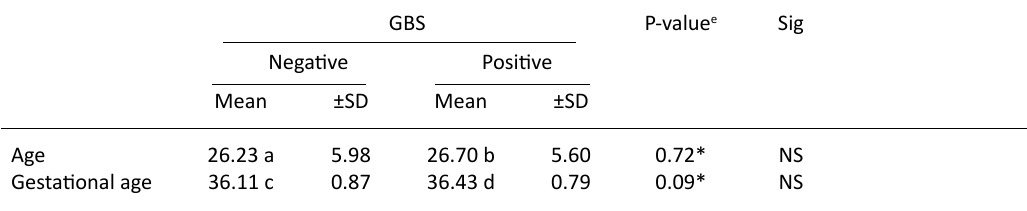
Table 2. Relationship between parity and GBS result among cases Parity P-value a Sig P0 P1-2 P3-4 N % N % 93.0%